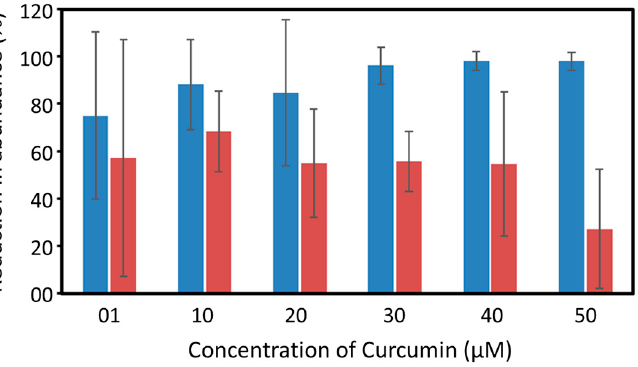
Figure 4. Reduction in the abundance of viable Vibrio spp. colonies in water (blue) and post larvae of P. monodon (red) on exposure to different concentrations of photoexcited curcumin. Results are presented as average ± standard deviation (sd).